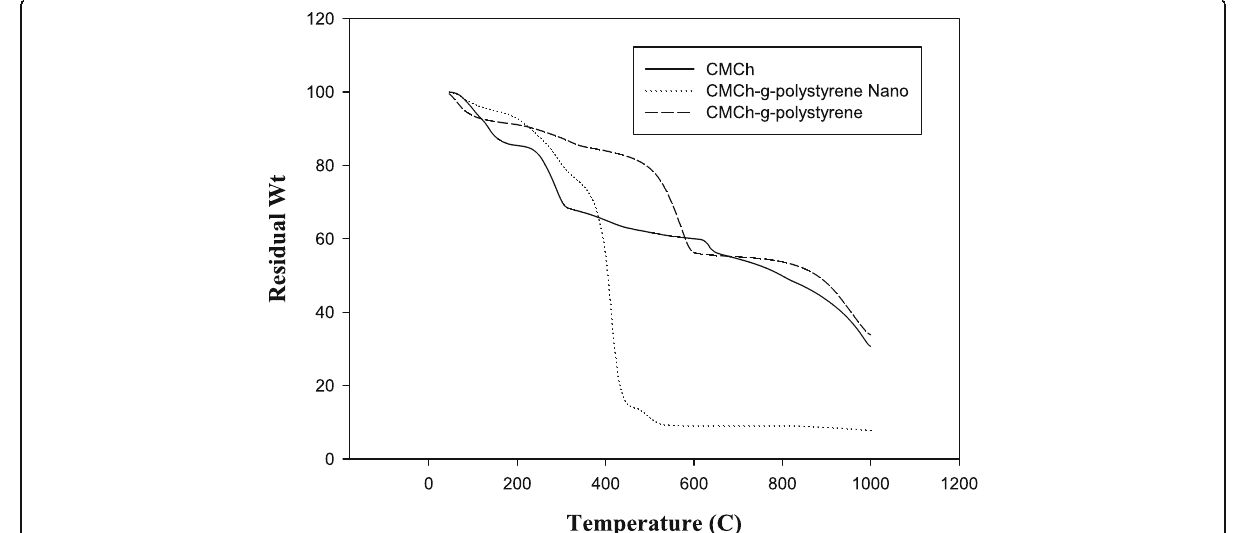
Fig. 9 Thermal analysis of ( a ) CMCh, ( b ) CMCh-g-S, and ( c ) CMCh-g-S nano under N 2 atmosphere